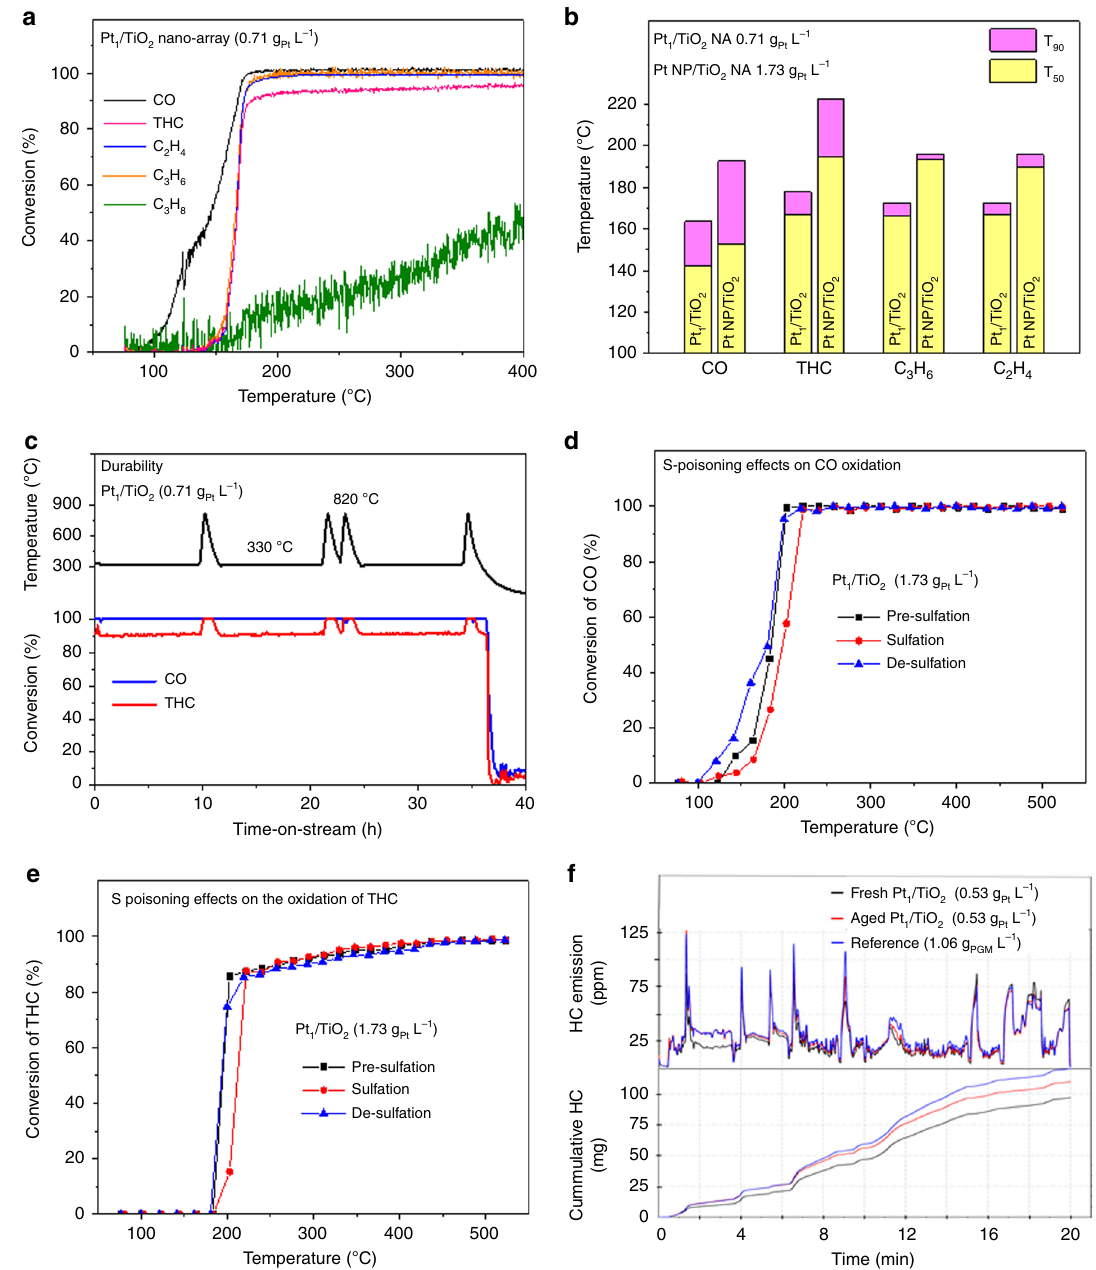
Fig. 3 Diesel oxidation performance of Pt 1 /TiO 2 NA integrated monoliths. a Light-off curves for Pt 1 /TiO 2 NA (0.71 g Pt L − 1 ) in the CDC simulated exhaust. b Comparison of the DOC activity in the CDC simulated exhaust between P 1 /TiO 2 NA (0.71 g Pt L − 1 ) and Pt NP/TiO 2 NA (1.73 g Pt L − 1 ). c Durability of the Pt 1 /TiO 2 NA in the simulated exhaust. d , e Sulfur-poisoning effects on the DOC activity of Pt 1 /TiO 2 NA (1.73 g Pt L − 1 ) in the LTC-D simulated exhaust. f Transient (upper panel) and cumulative (lower panel) THC emission in the transient gas conditions mimicking a HDD FTP as running on a HDD certi fi ed 2010 Cummins ISB (6.7 L) 320 hp engine for fresh (blue) and aged (red) Pt 1 /TiO 2 NA (0.53 g Pt L − 1 ). A commercial DOC monolith with double PGM loading (1.06 g L − 1 ) was employed as the